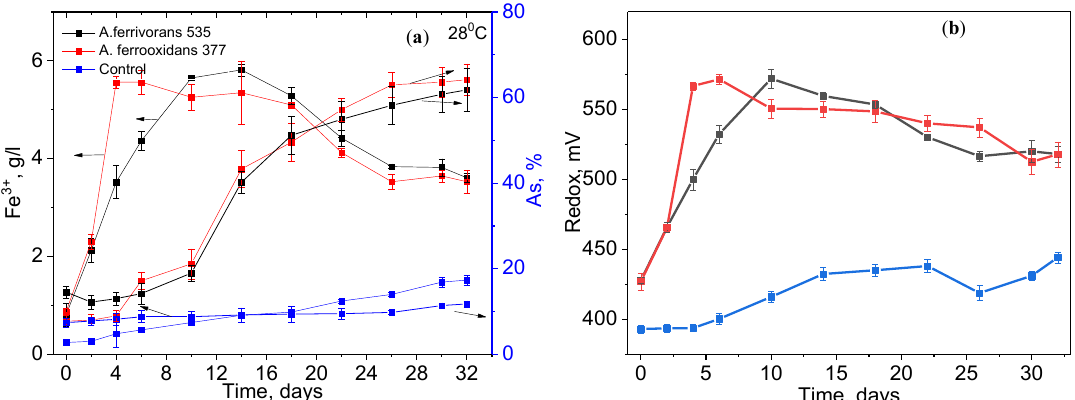
Figure 3. Ferric (Fe 3+ ) concentration ( a ), solution redox potential, and As removal efficiency ( b ) during the bioleaching experiments with different strains at 28 °C.